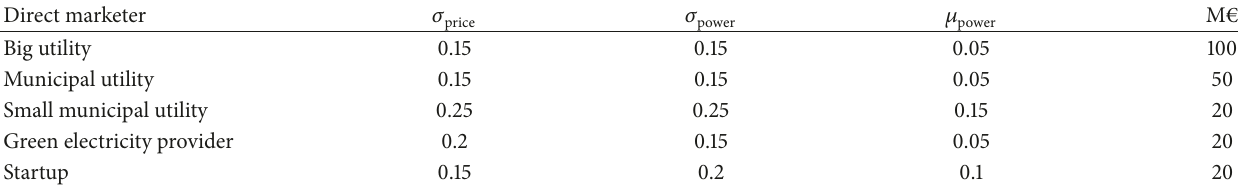
Table 7: Table representing the direct marketers’ initial forecast uncertainties and capital resources.